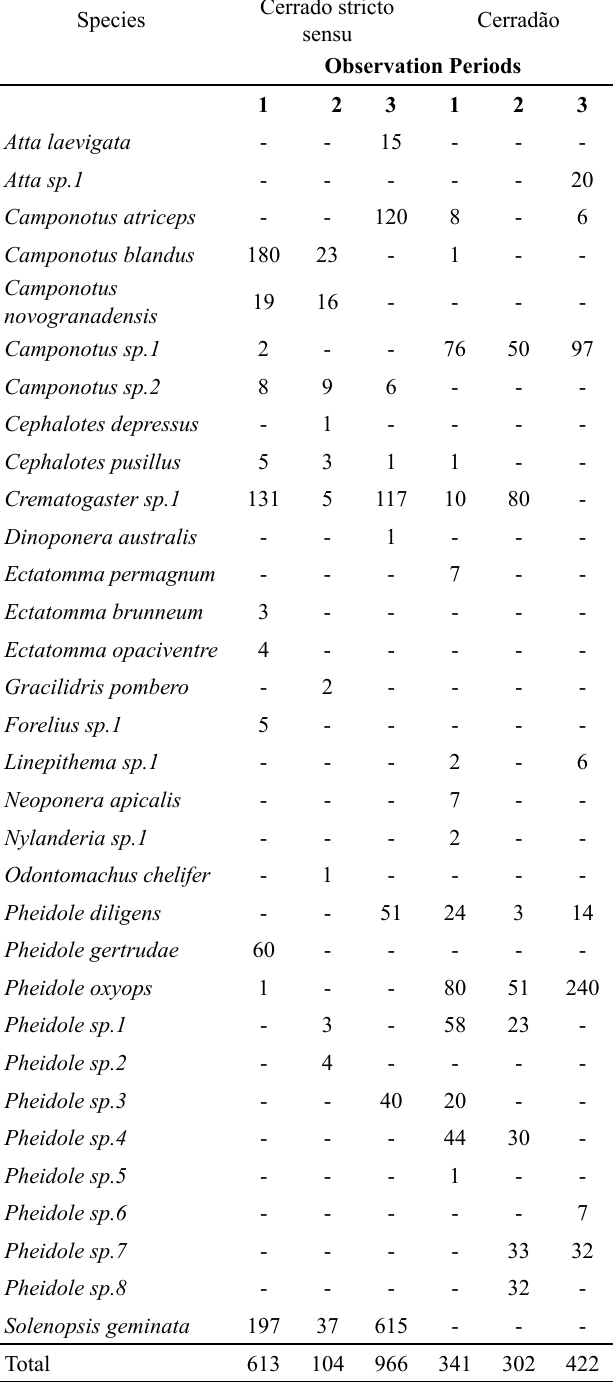
Table 1 . The recruitment of ant species observed in each cerrado area and period of observation.